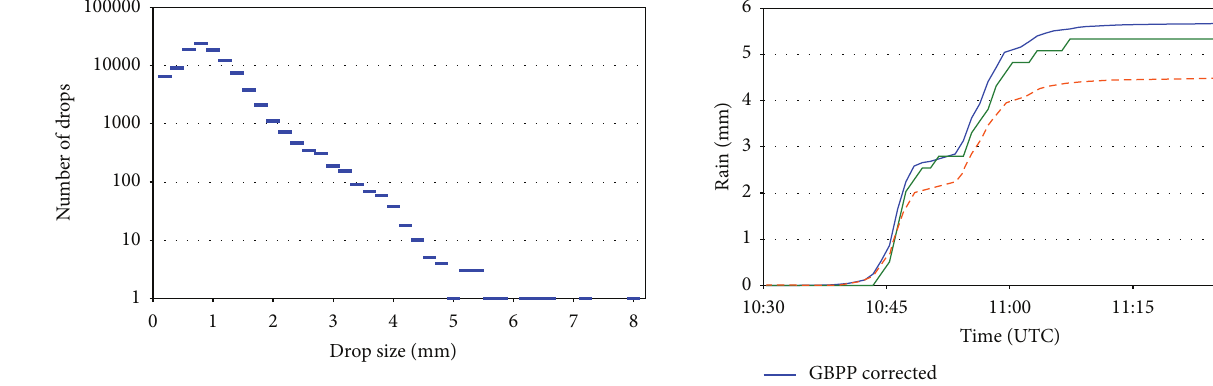
Figure 9: Drop size distribution of all raindrops recorded on April 16, 2006.